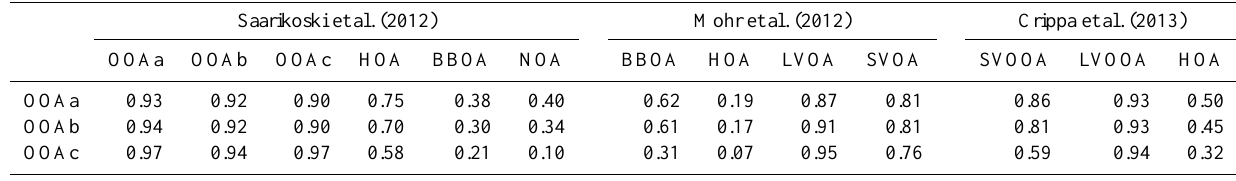
Table 3. Pearson correlation coefficients ( R ) between the profiles of the three PMF factors and reference high-resolution factor profiles found in the literature.